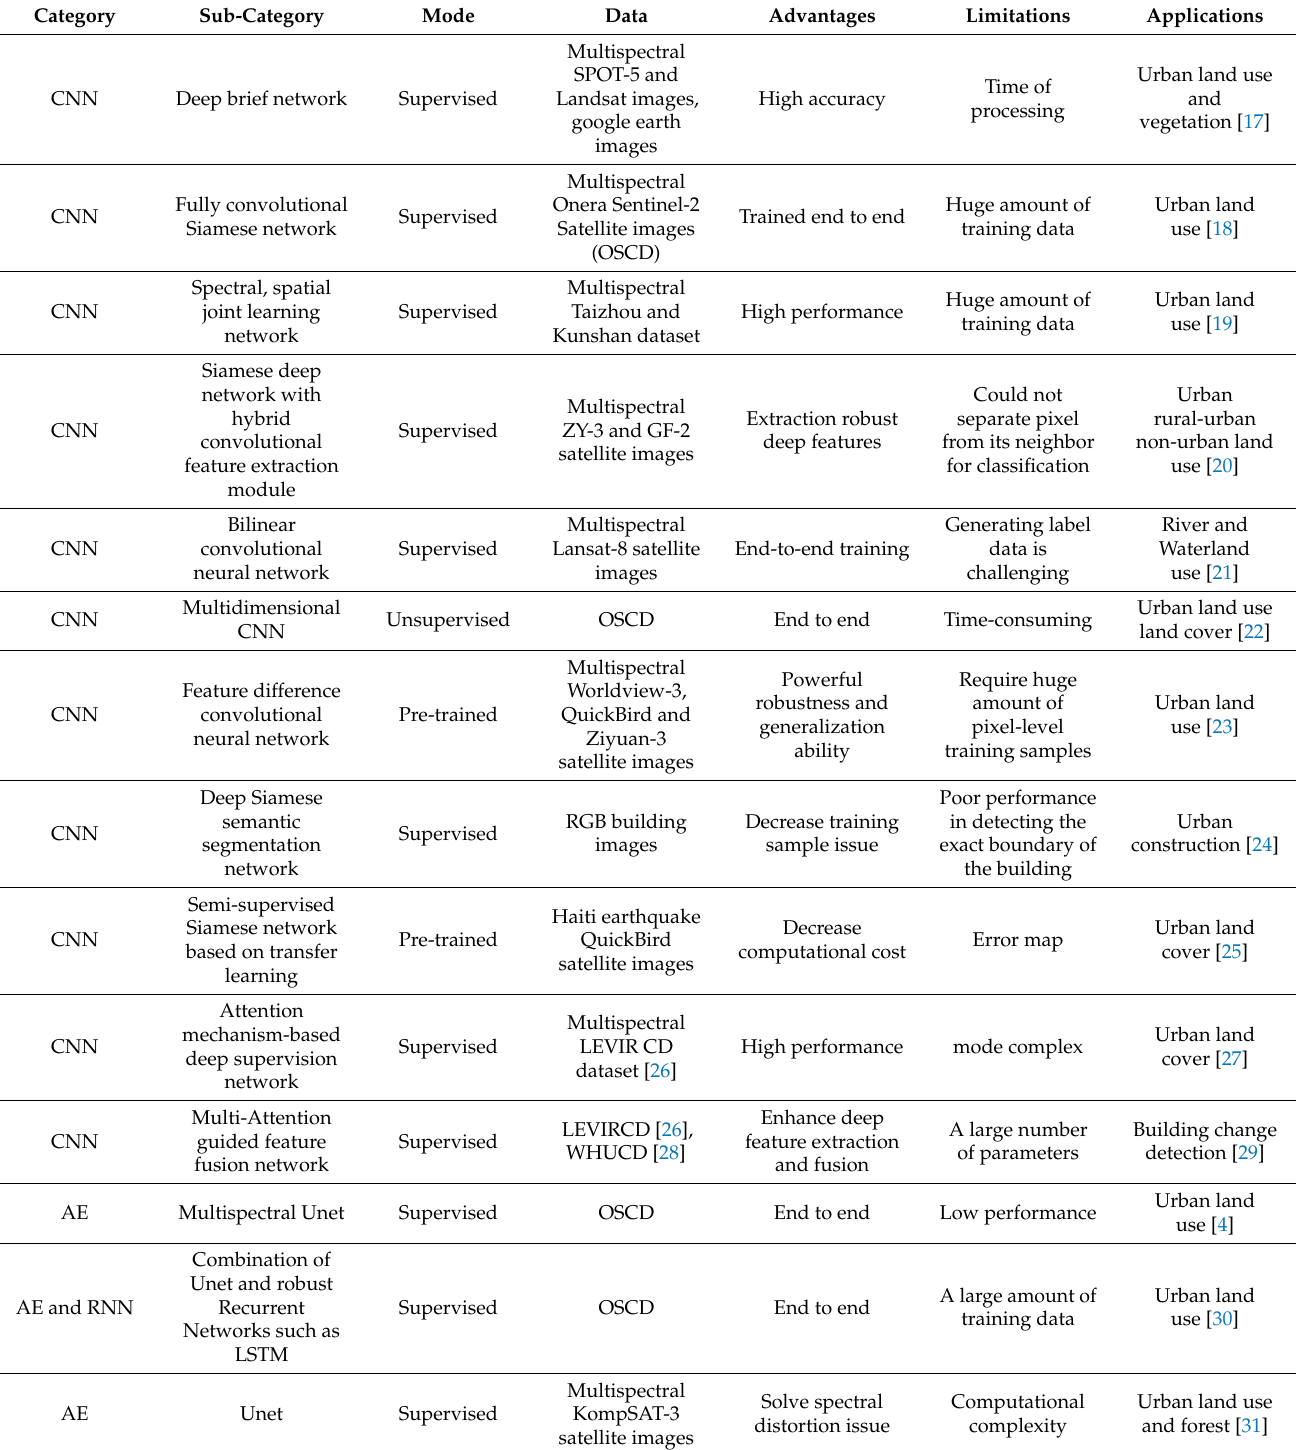
Table 2. Literature review of deep learning change detection